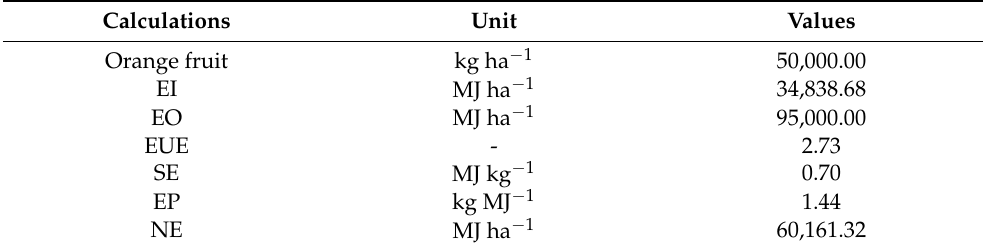
Table 4. Calculations of the energy use efficiency in the production of oranges.